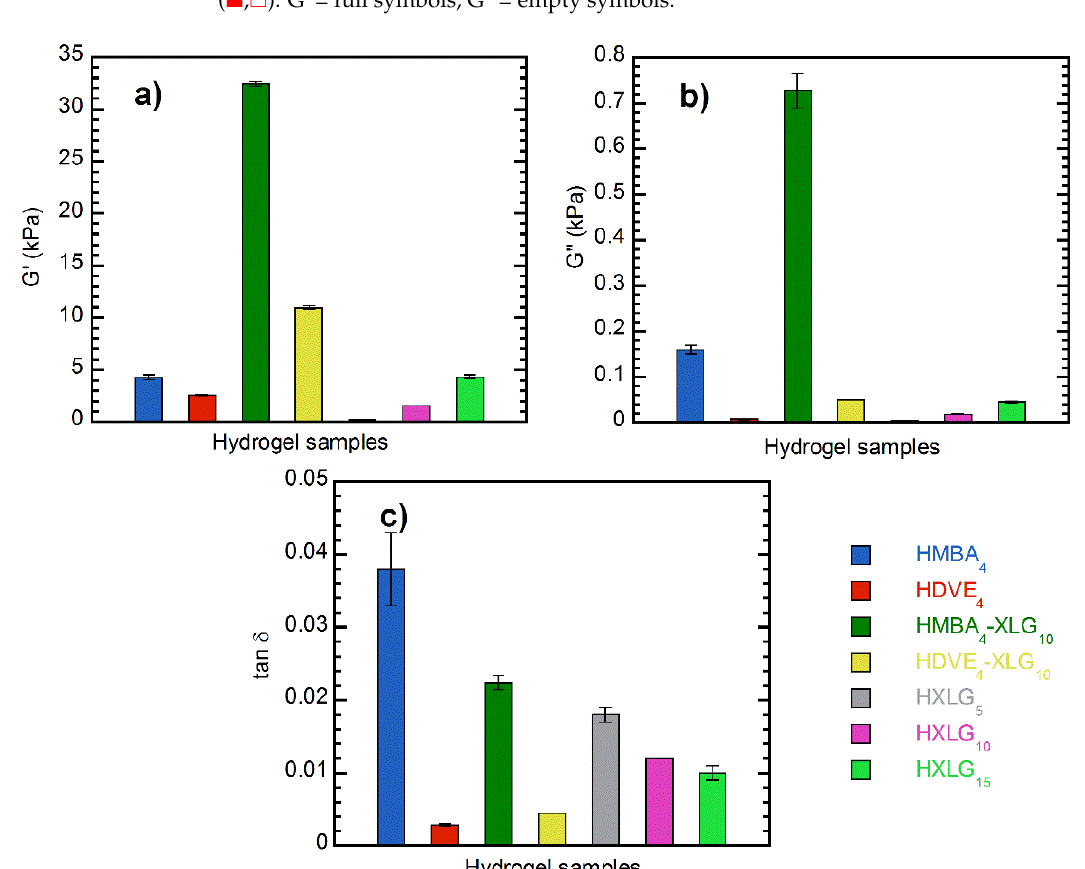
Figure 10. Frequency sweep rheological measurements of the hydrogel samples synthesized: ( a ) storage modulus; ( b ) loss modulus; ( c ) loss factor. Values recorded at 1 Hz frequency. According to the phantom model adapted by Peppas and coworkers [76] to real swollen hydrogels, G’ is, besides other network parameters, directly proportional to the polymer fraction in the swelled hydrogel to the 1/3 power and inversely proportional to the number average molecular weight between crosslinks (M c ). A lower polymer fraction means a higher swelling degree, while a smaller M c is equivalent to a higher degree of crosslinking/network density. Therefore, G’ should be smaller for higher swelling degrees as well as for lower crosslinking degrees/network densities and larger for reduced swell-